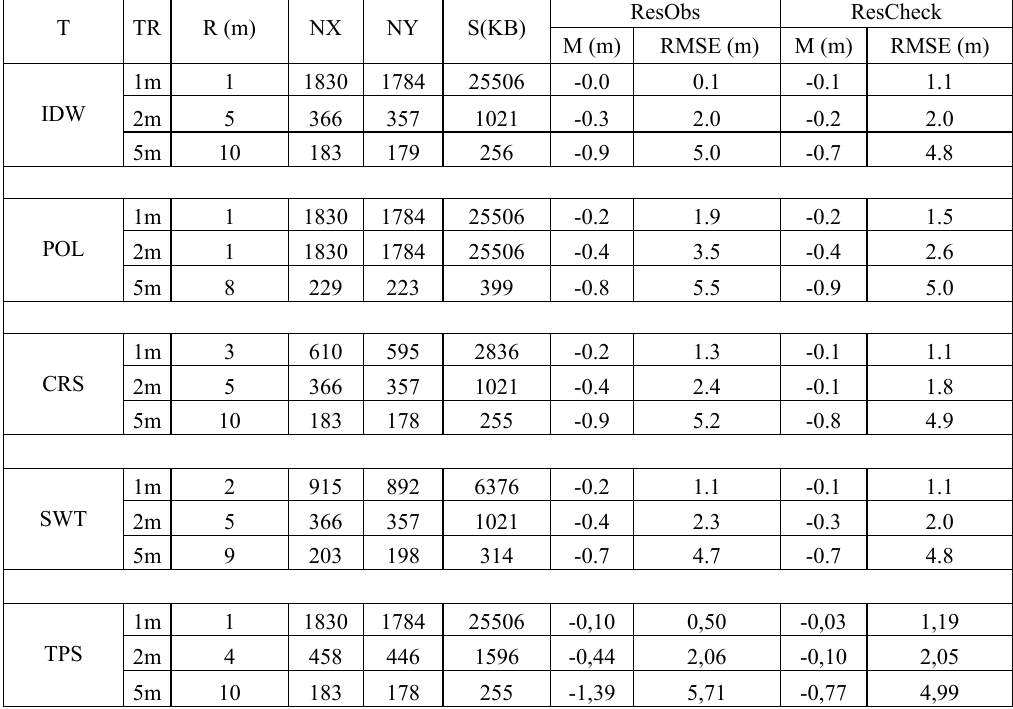
Table 3. Characteristics of the interpolated grids. T: technique used to interpolate; TR: interpolated dataset; R: final resolution; NX and NY: number of nodes in X and Y; S: storage size; ResObs, ResCheck: statistics of the residuals on the used observations and the check points; M: mean; RMSE: root mean square error.